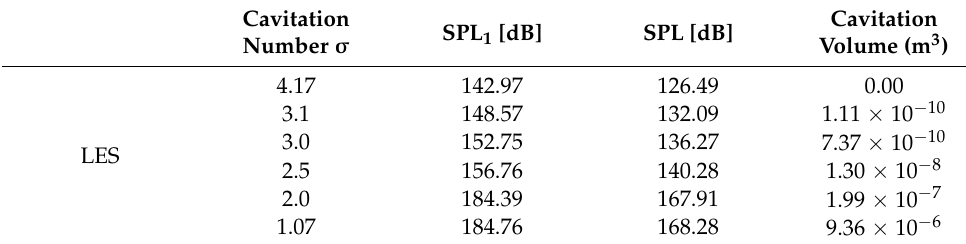
Figure 14. Condition of simulation ( left ) and SPL-frequency graph of wall pressure ( right ) according to cavitation number. Table 11. SPL 1 , SPL, and cavitation volume according to cavitation